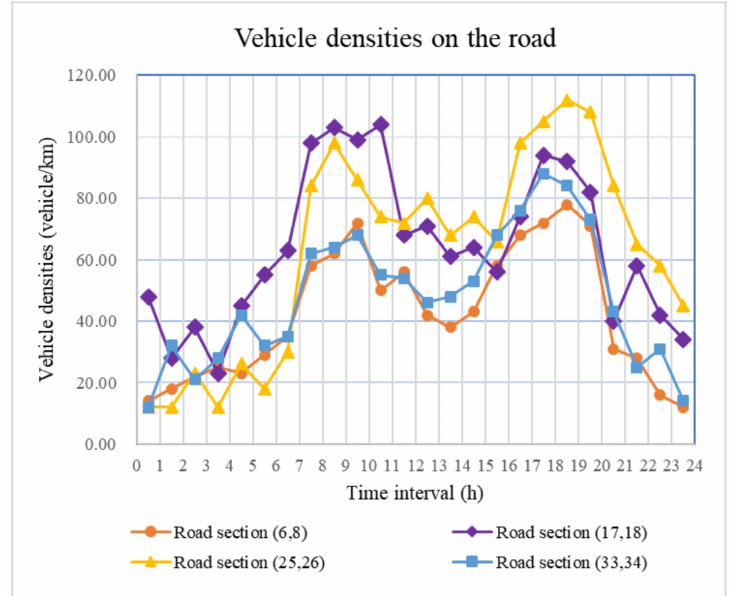
Figure 7. Vehicle densities on the roads.